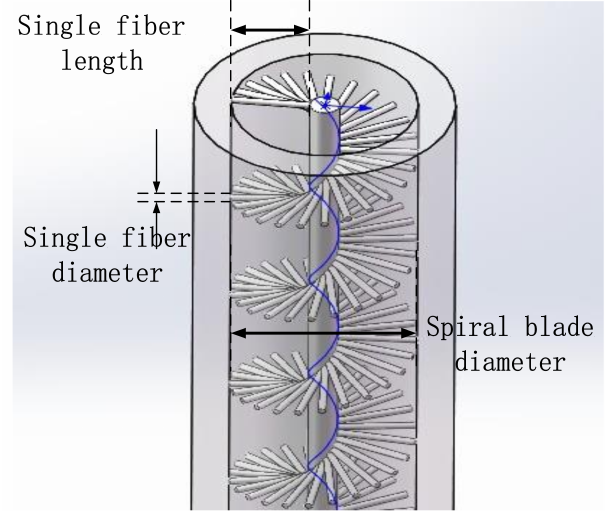
Figure 3. Flexible blade